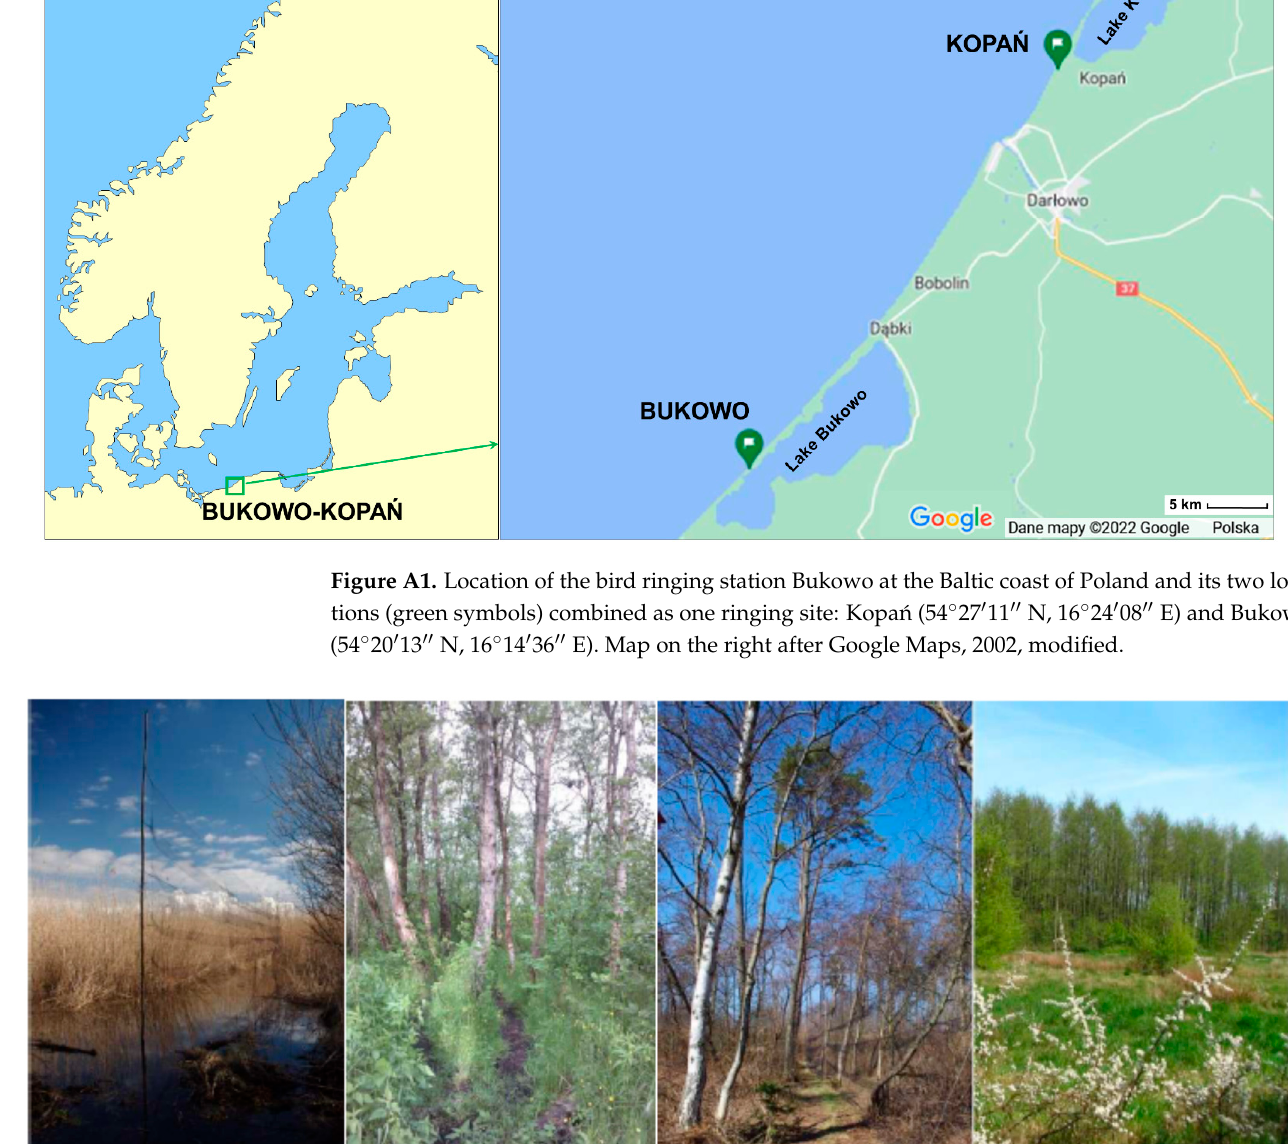
Figure A2. Habitats where birds were mistnetted at the bird ringing station Bukowo (54°20 ′ 13 ″ – 54°27 ′ 11 ′ N, 16°14 ′ 36 ″ –16°24 ′ 08 ″ E). Photos: Katarzyna St ę pniewska. Appendix